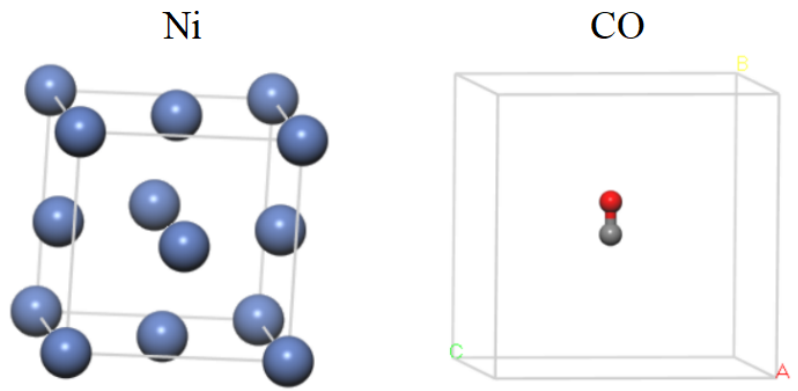
Figure 1. Optimized bulk Ni cell and CO molecule.